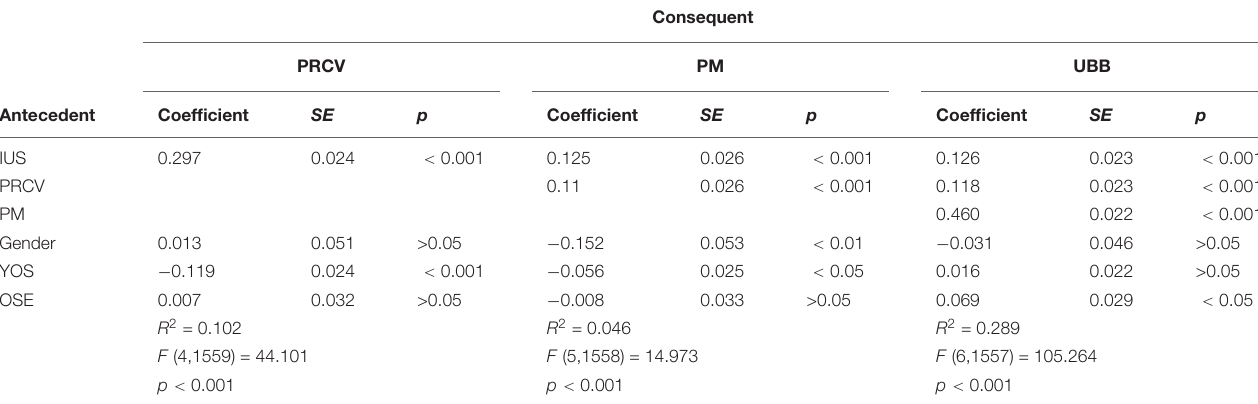
TABLE 2 | Regression coefficients and standard errors for the serial mediation model presented in Figure 2 .